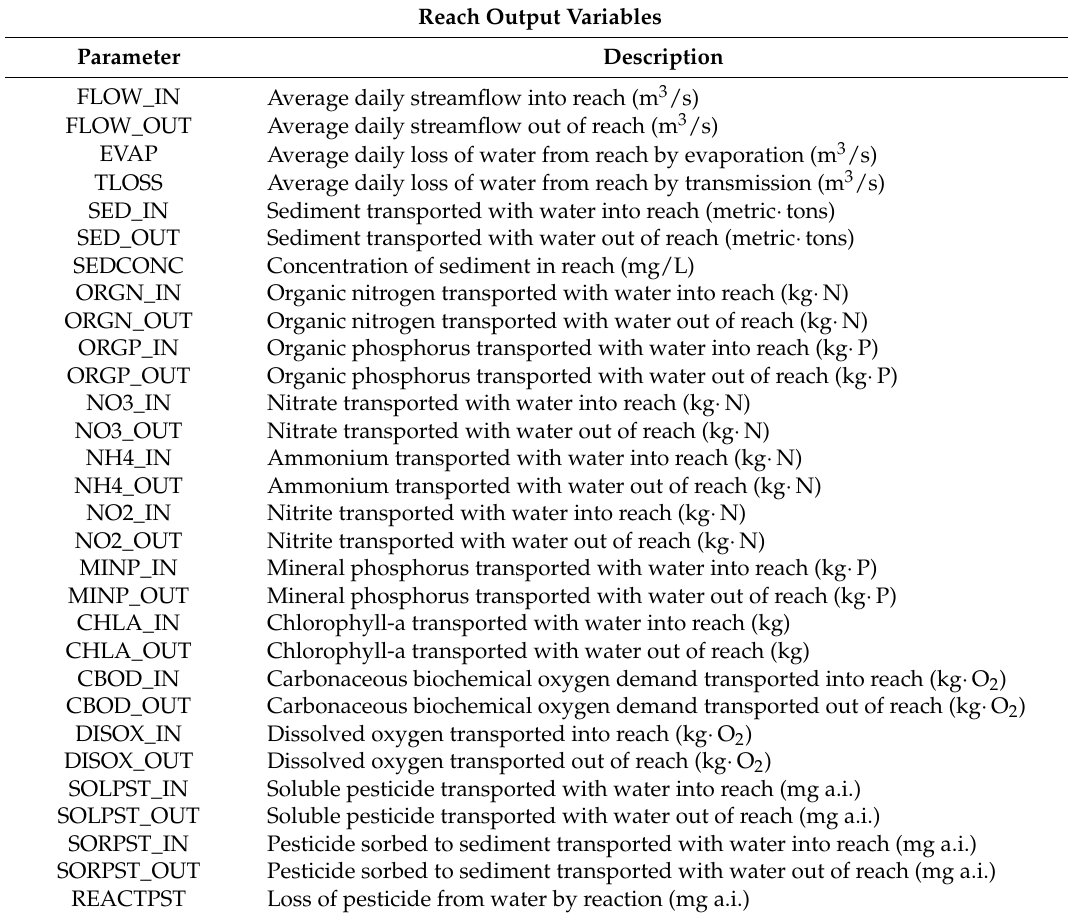
Table C1. Printable SWAT variables for reach